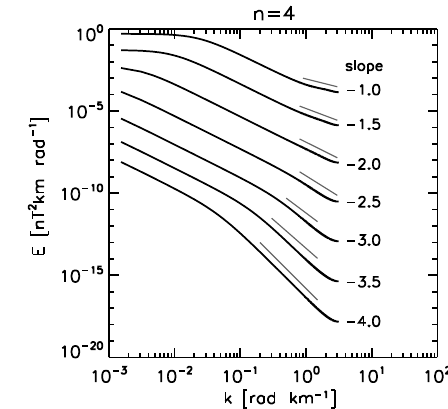
Figure 3. Minimum variance spectra for different slopes using four sampling points. Gray lines indicate the true spectral slope.